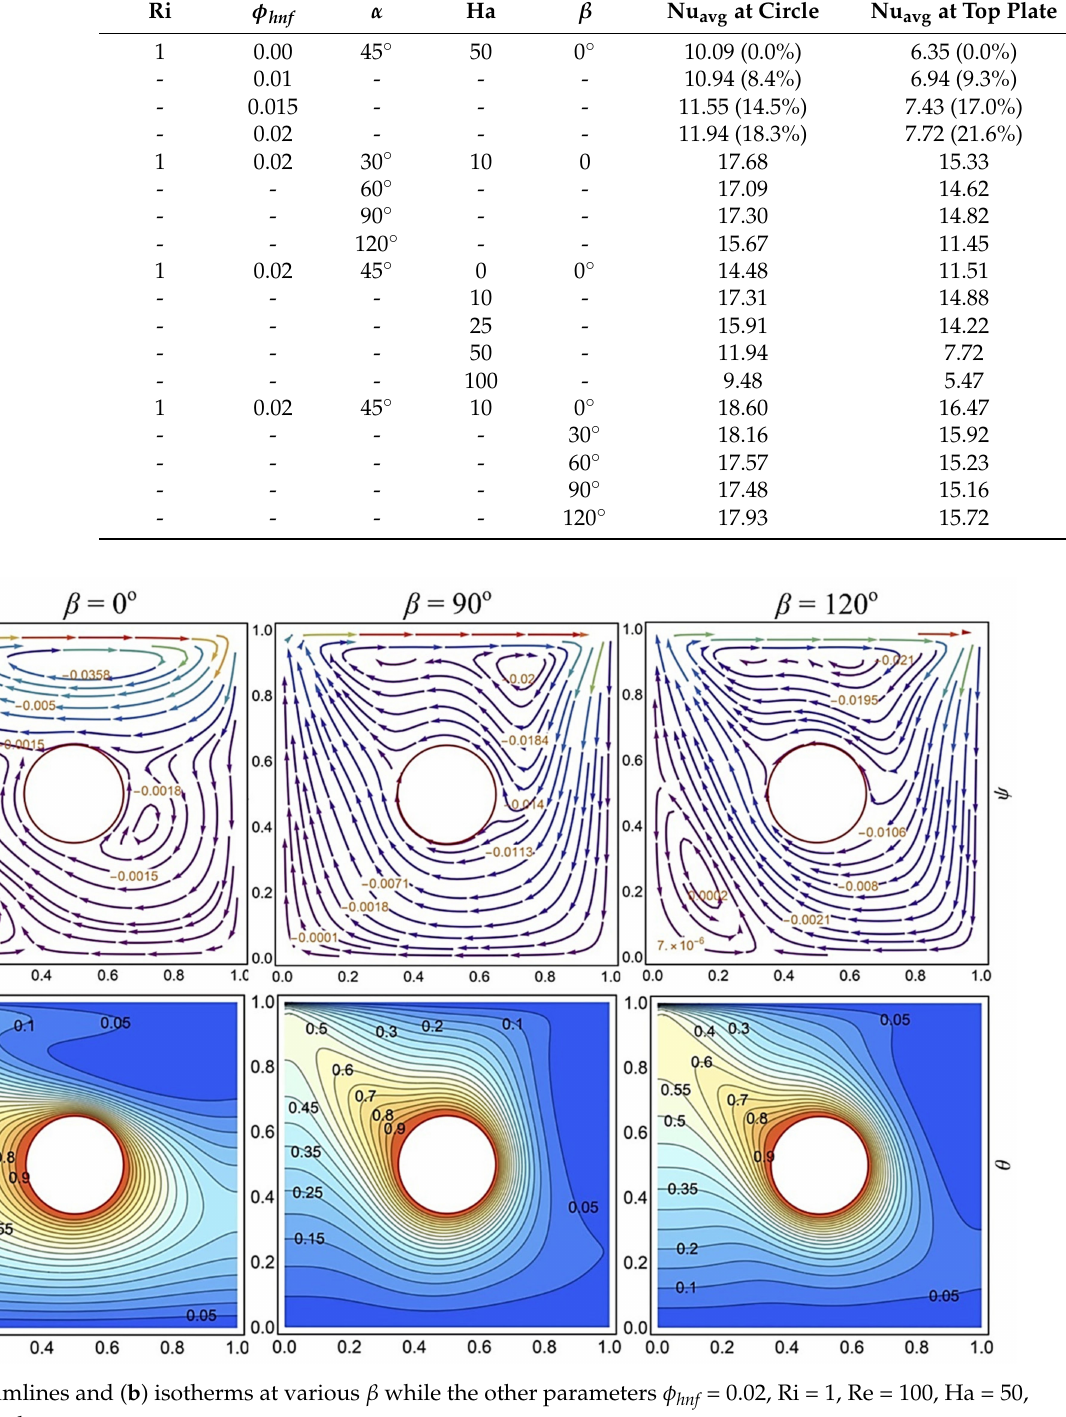
Figure 9. ( a ) Streamlines and ( b ) isotherms at various β while the other parameters φ hnf = 0.02, Ri = 1, Re = 100, Ha = 50, α = 0 ◦ are kept